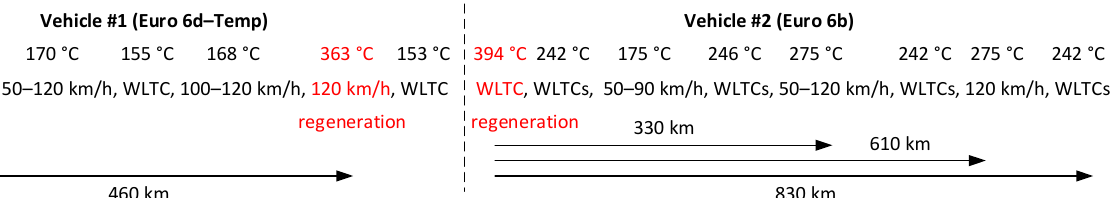
Table 1. Characteristics of the two vehicles tested.